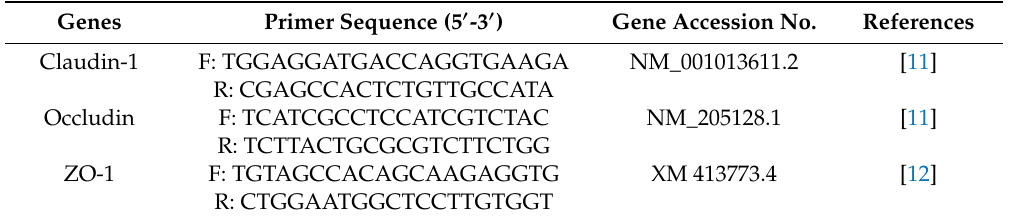
Table 2. Sequences of the primers used for the determination of gene expression levels. Genes Primer Sequence (5 (cid:48) -3 (cid:48) ) Gene Accession